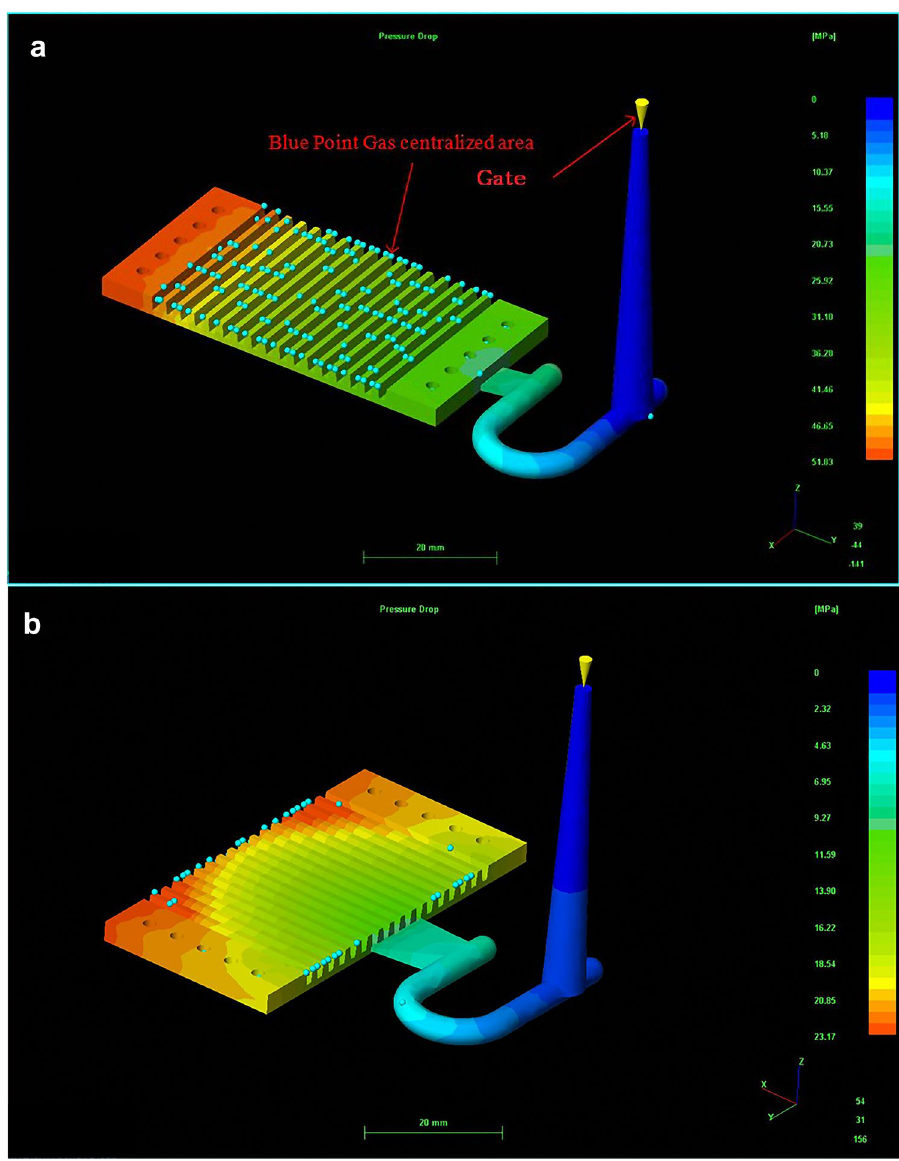
Figure 9. Air traps in injected PMMA bipolar plate for two different design: ( a ) top and ( b ) side (Version number: MOLDFLOW ADVISER 2019, URL link: https:// www. autod esk. com/ produ cts/ moldfl ow/ overv